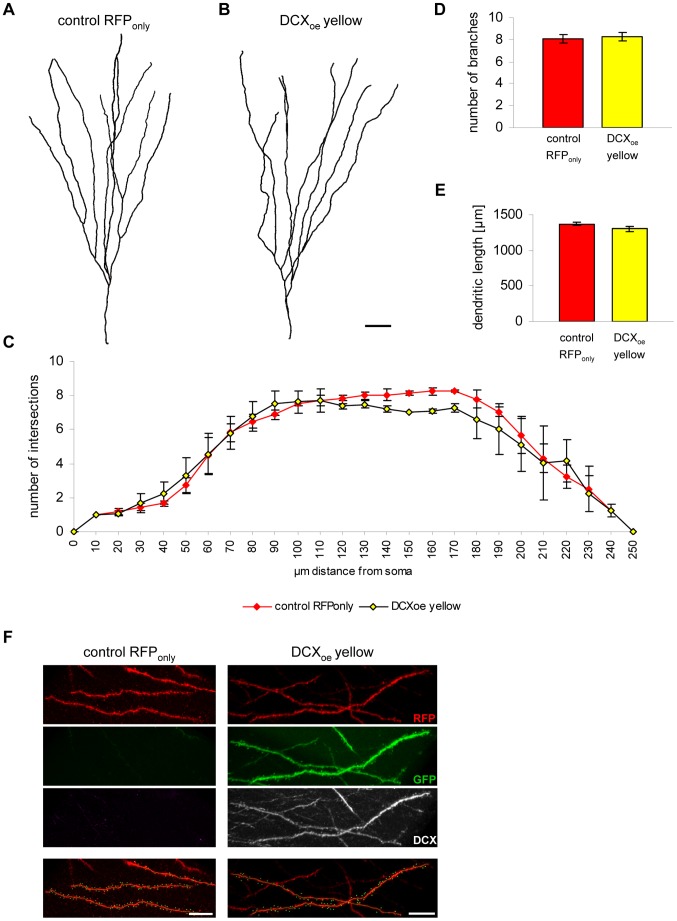
Prolonged DCX expression has no influence on morphological maturation of 28 days old dentate granule cells.(A–B) 3D reconstruction of an RFPonly (A) and a DCX-overexpressing yellow (B) granule neuron. Scale bar 20 µm. (C) Scholl analysis reveals no major changes in complexity in DCX overexpressing yellow cells compared to RFPonly control cells (n = 3 animals). (D–E) Quantification of the number of branch points and the total dendritic length in RFPonly- and DCX-transduced yellow cells (n = 3 animals). (F) Spine analysis of an RFPonly and a DCX-overexpressing yellow cell. Green dots represent one spine. Scale bars 10 µm.